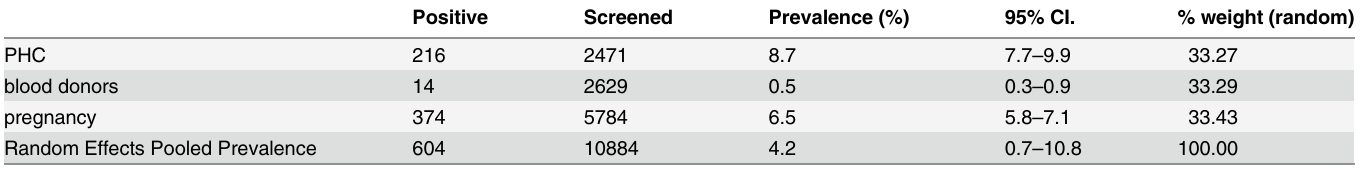
Table 2. Heterogeneity of pooled prevalence estimates of Chagas disease by type of study recruitment setting. Positive